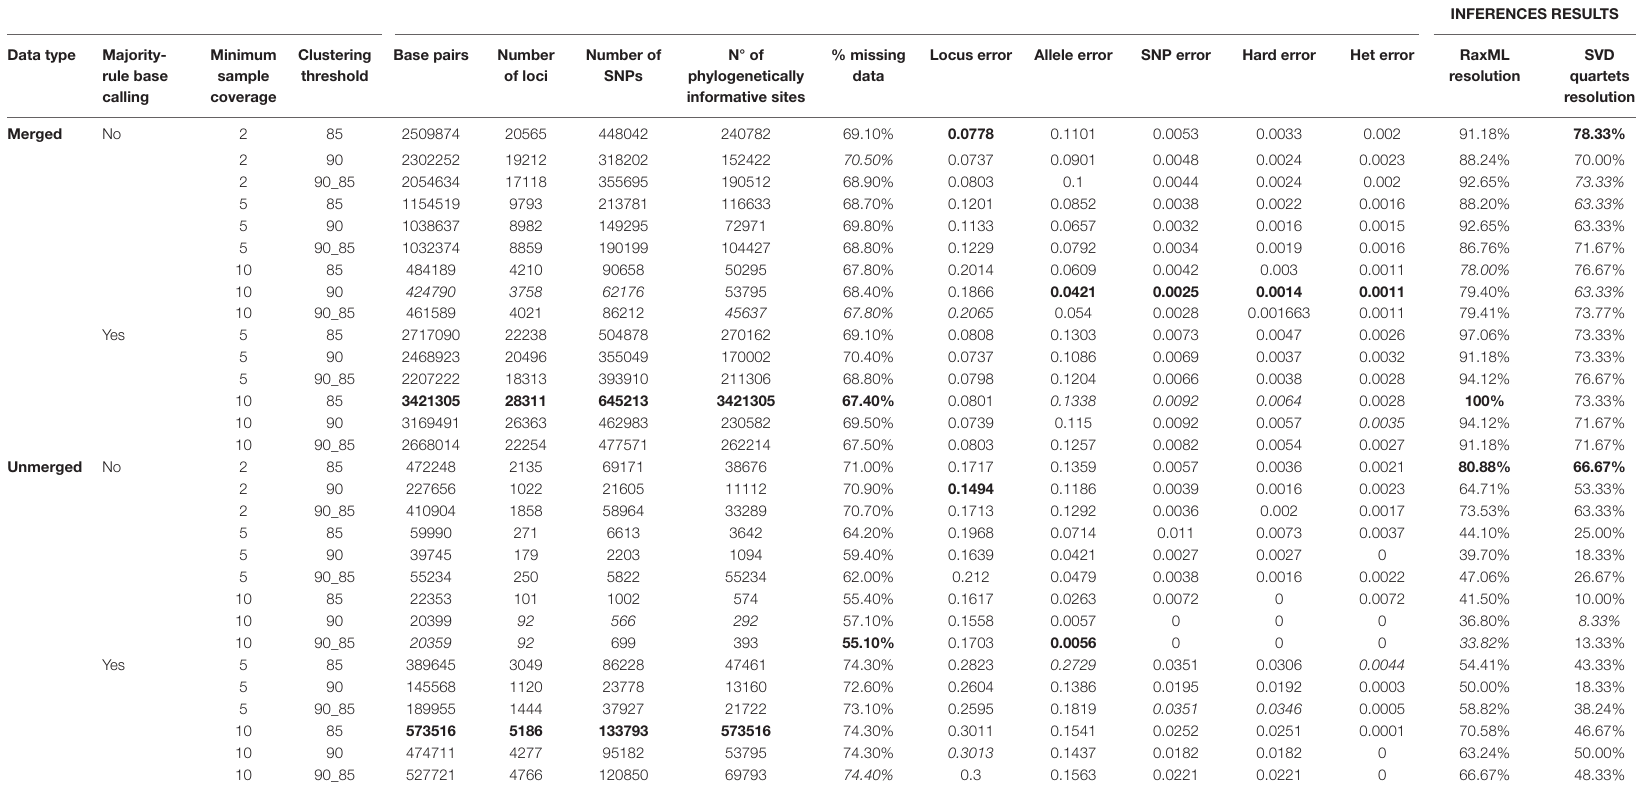
TaBlE 1 | Assembly information obtained from the exploratory PyRAD assembly using the subset of 70 samples. PYRaD PaRaMETERS